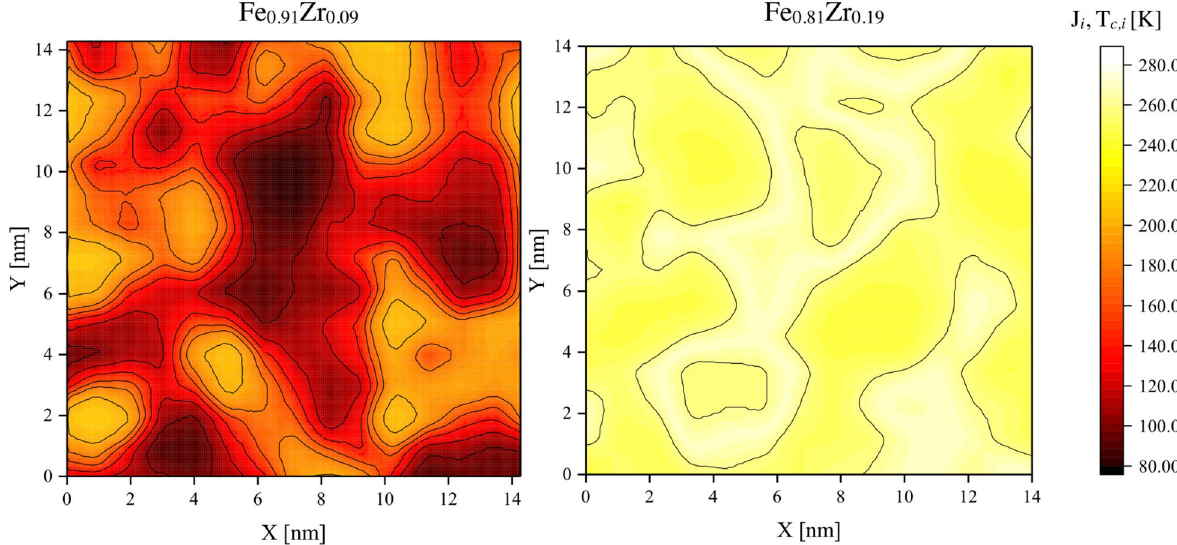
Fig. 4. Changes in the effective coupling strength with concentration in the Fe 0.91 Zr 0.09 (left) and Fe 0.81 Zr 0.19 (right) alloys, expressed as T c , i . The contour lines in both colormaps depict isolines with an interval of (cid:31) T c , i = 20K . Large difference between these concentrations are inferred, reflecting the change in the effective exchange coupling with concentration.